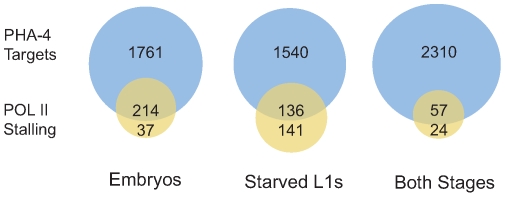
Genes displaying RNA Pol II stalling are preferentially bound by PHA-4.Pie charts showing the fraction of genes with an RNA Pol II stalling index >4 [25] bound by PHA-4 for genes with either stage-specific PHA-4 binding or shared PHA-4 binding.